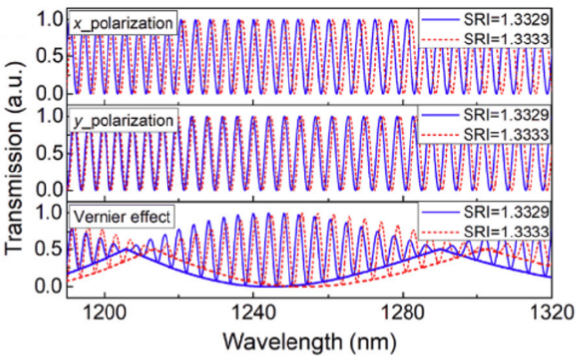
Figure 10. The wavelength shifts comparison of x-polarization, y-polarization, and with the Vernier effect. Reprinted with permission from [129].